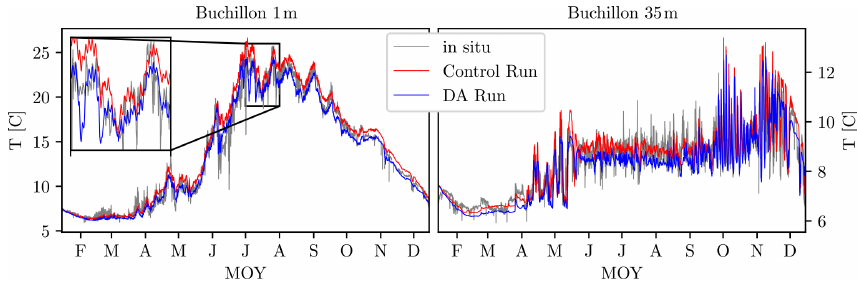
Figure 7. Evolution of temperature at the Buchillon station for the 1m (left) and 35m (right) sensors for the year 2019. The gray line is the in situ measurement, the red line corresponds to the control run, and the blue line is the data-assimilated prediction. The small inset on the left shows the improvement from the assimilated run for the 1m sensor in greater detail for